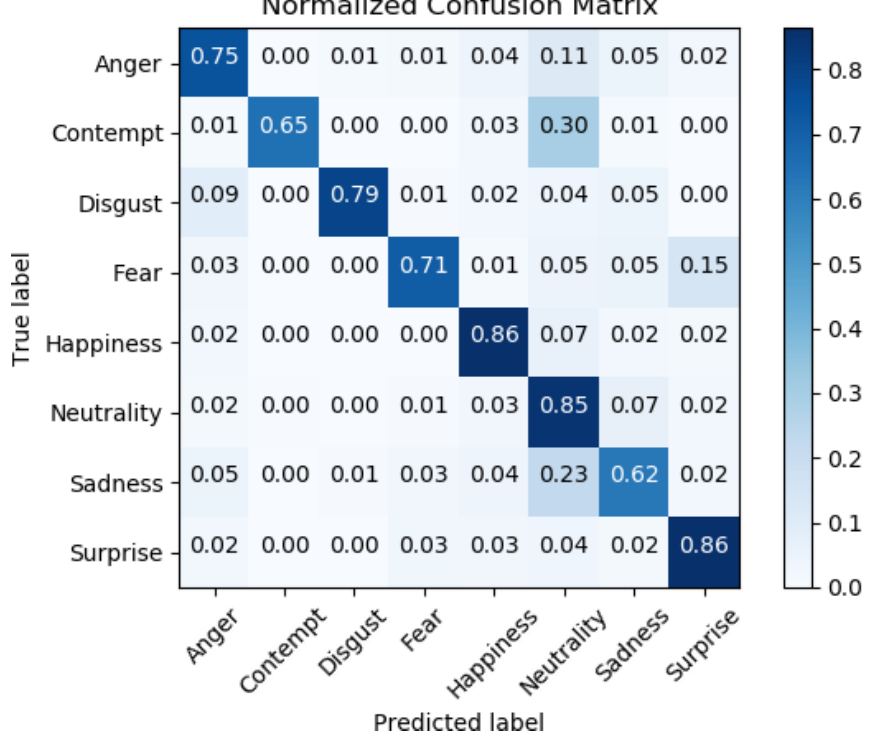
Figure 10. Normalized confusion matrix of the network in [21], trained with the Ensemble 1 database using the data augmentation and the z-score normalization. Figure from